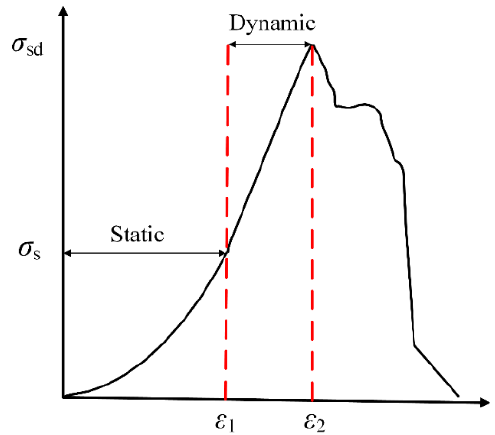
Figure 2. The scheme for the loading path of superimposed static and dynamic loads: σ s represents the applied static pre-stress and σ sd represents the superimposed strength of the specimen. Table 2. Loading schemes.